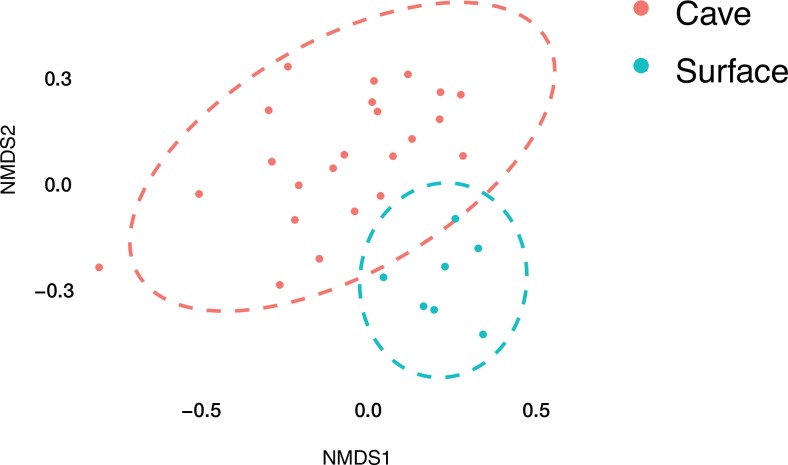
NMDS (Non-Metric Dimensional Scaling).NMDS separates out lava cave mat communities at the phylum level, with Proteobacteria split out by class, from the overlying surface soils. Circles show the 95% confidence interval.